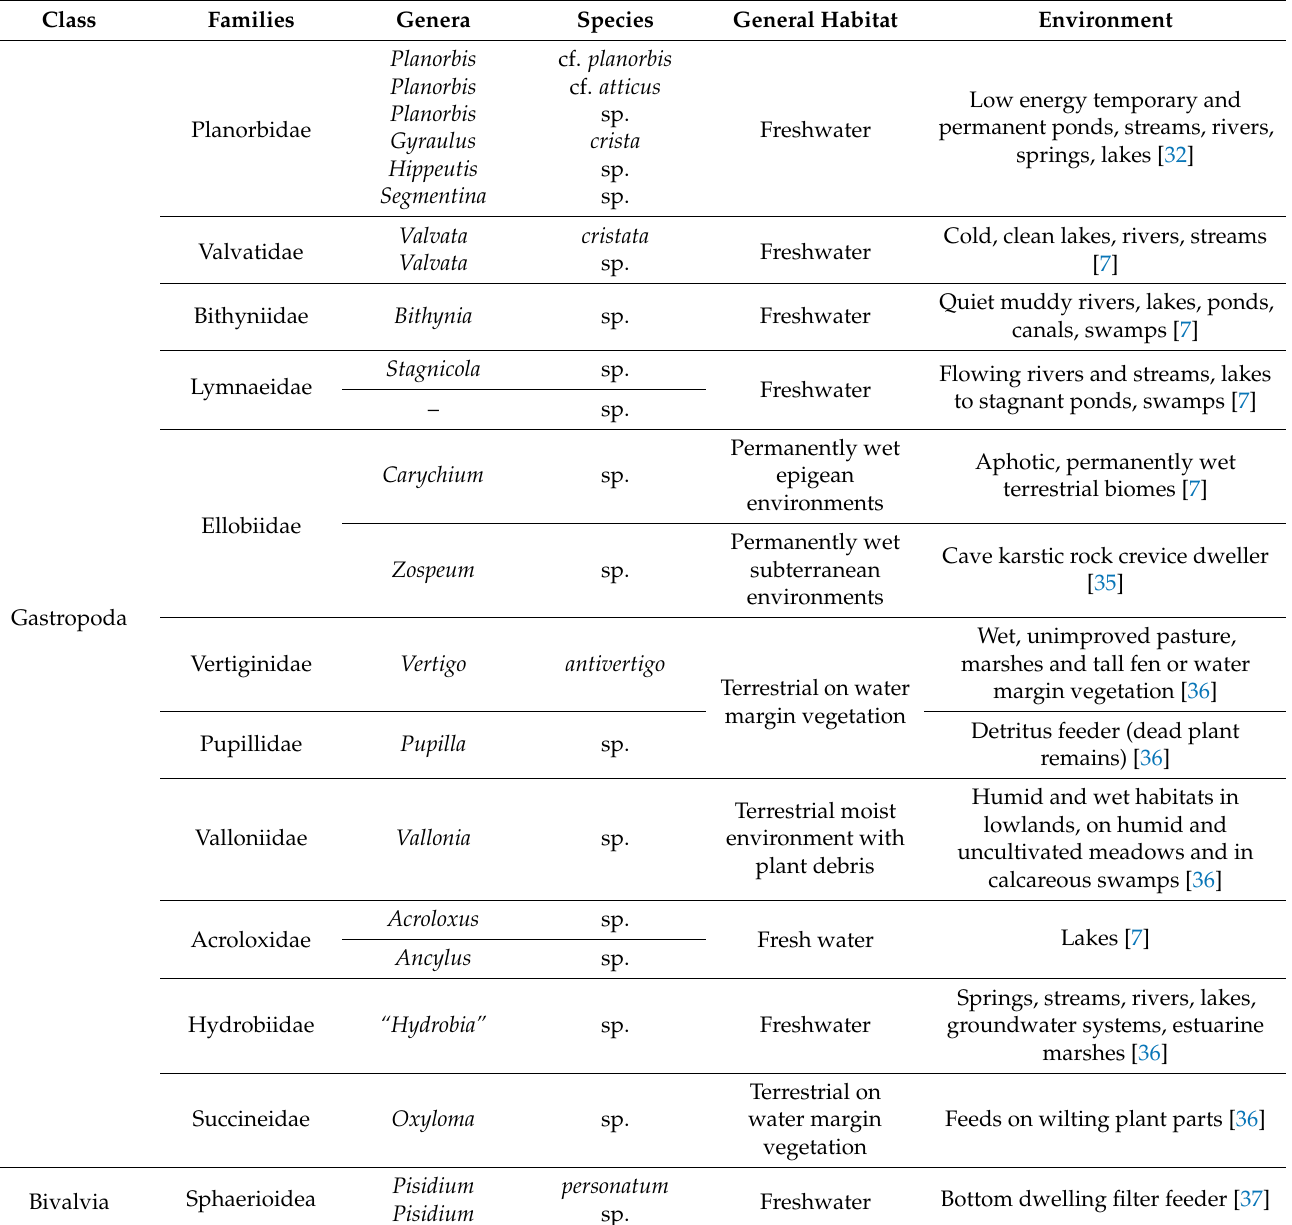
Table 2. List of molluscs found in sediments of Lerna and their respective habitats and